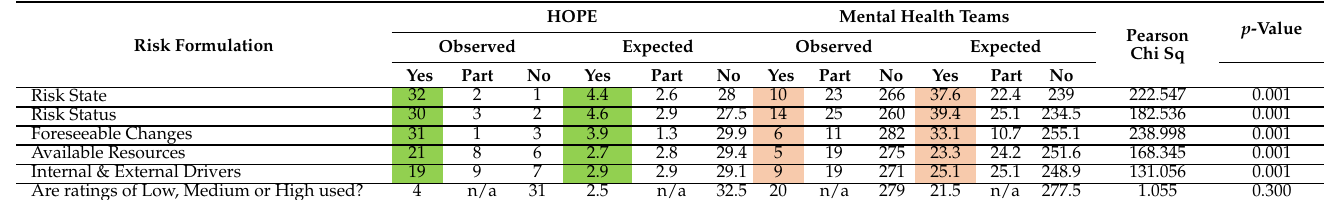
Table 4. Risk Formulation. Assessment. Key—Green: above expected and Orange: below expected.